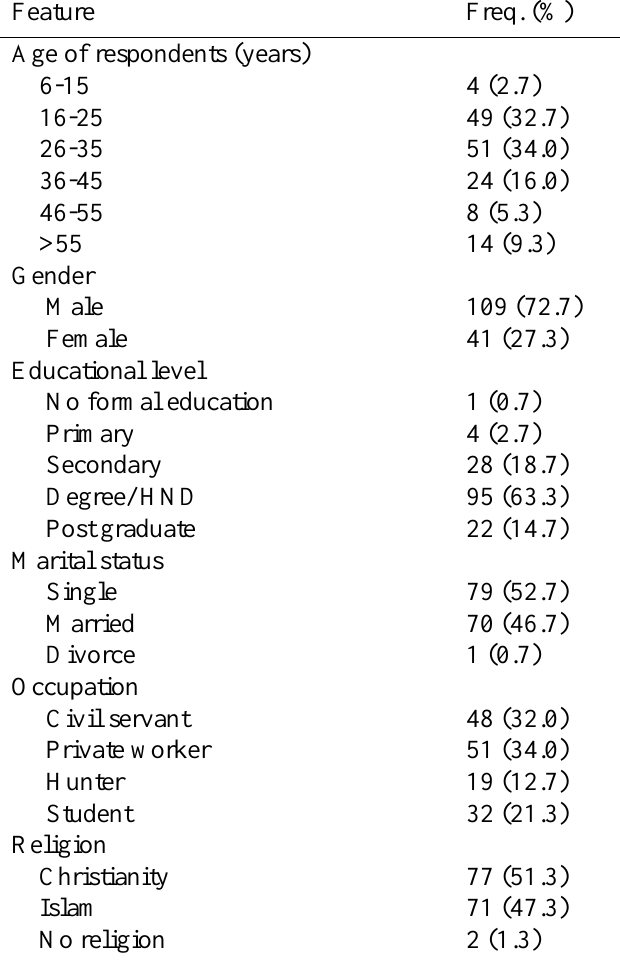
Table 1: Socio-demographic characteristics of the dog